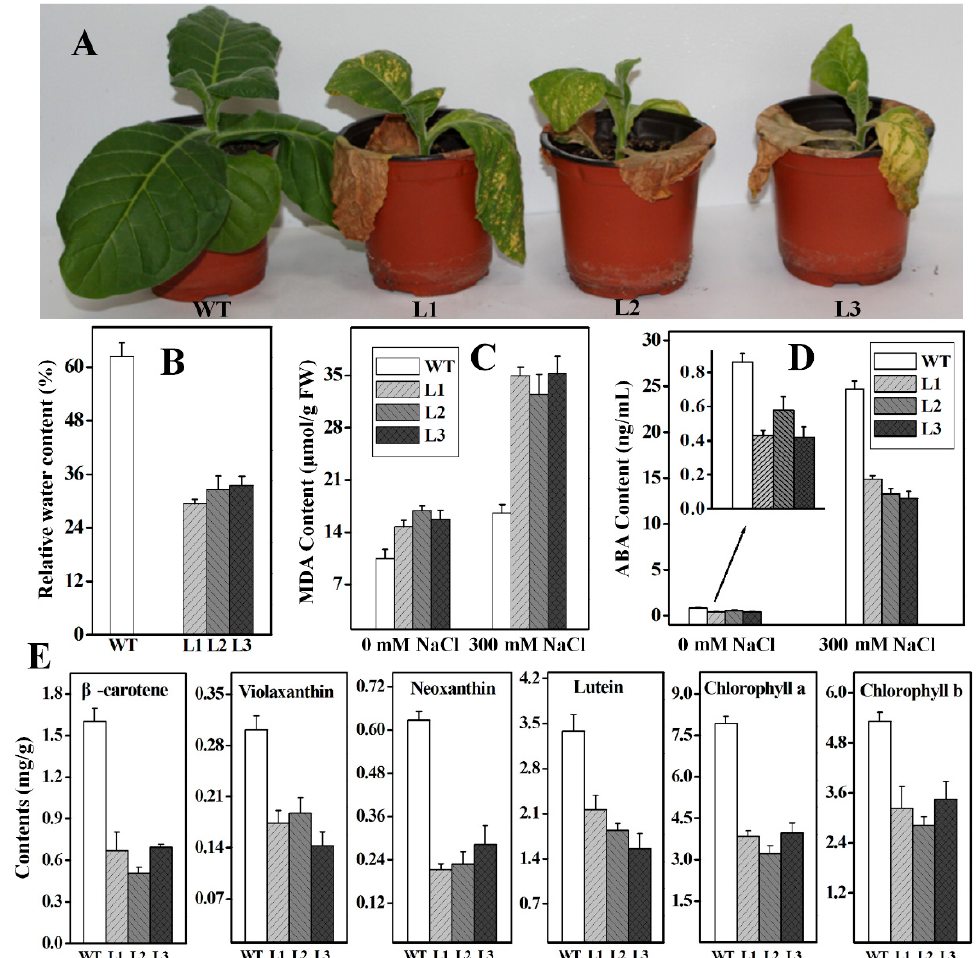
Figure 8. Effects of salt stress on Nt β -LCY1 RNAi transgenic plants. ( A ) Phenotypes of WT and Nt β -LCY1 RNAi plants under salt stress for eight days; ( B ) Relative water content in WT and RNAi plant leaves after salt stress for two weeks; ( C , D ) Malondialdehyde (MDA) and abscisic acid (ABA) content in leaves of WT and RNAi plants with or without salt stress; ( E ) Carotenoid and chlorophyll content in WT and Nt β -LCY1 RNAi transgenic plants after two weeks of salt treatment. Error bars represent standard deviation ( n = 6). The data presented here are representative of three independent experiments.